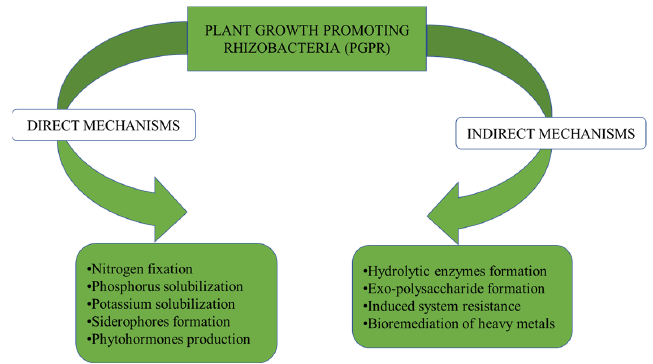
Figure 1. Mechanisms of plant growth ‐ promoting rhizobia.